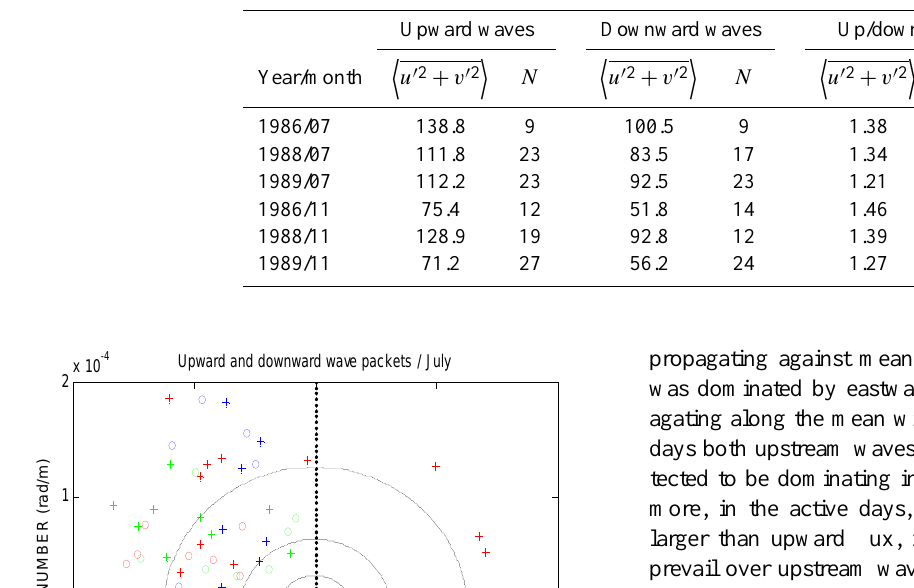
D E u 0 2 + v 0 2 Table 5. Mean energy , the number of potential wave packets N , and their up/down ratio for the different years and months. h···i represents average over all heights, and over-bar represents time average over all sampling days of the same month. The up/down ratio represents the ratio of the quantities of upward waves to the downward waves.